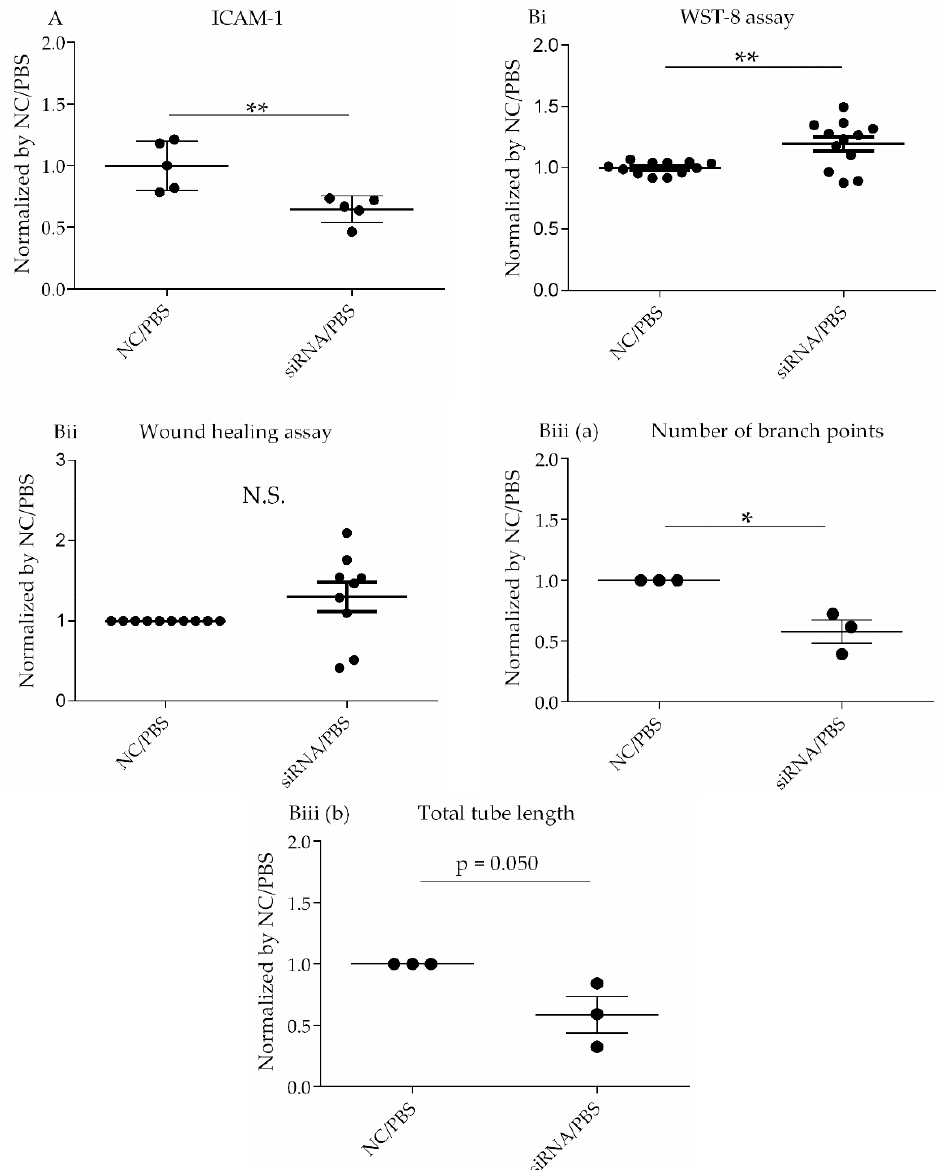
Figure 3. Confirmation studies of HLMVECs under baseline conditions. ( A ) Assessment of ICAM-1 expression level on HLMVECs. HLMVECs were transfected with non-specific or DPP4 -specific siRNA for 72 h, and then challenged with PBS for 18 h. ICAM-1 expression on HLMVECs was measured by mean fluorescence intensity (MFI) using flow cytometry analysis. ICAM-1 levels in cultured HLMVECs after siRNA treatment followed by PBS challenge are shown. * p < 0.05, ** p < 0.01, *** p < 0.001. The values are means ± SD of three or more independent experiments. N.S., Not significant; NC, Non-specific control; siRNA, DPP4 siRNA. ( B ) Assessment of regenerative process under base-